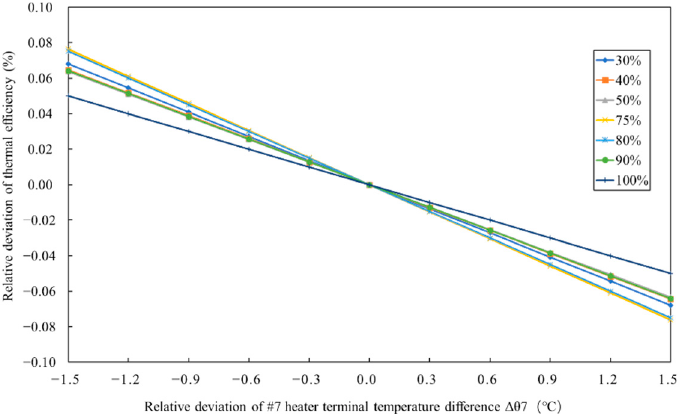
Figure 7. Variation in the relative deviation of thermal efficiency with #7 heater terminal temperature difference disturbance under different output power loads.